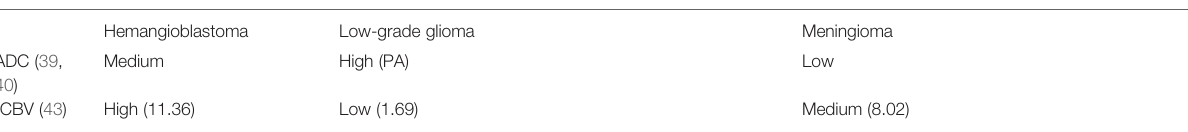
mimickingtheappearanceofatramtrack.Theobviouscalci fi cation onnoncontrastCTscansalsosuggestsONSMinsteadofONH(50).